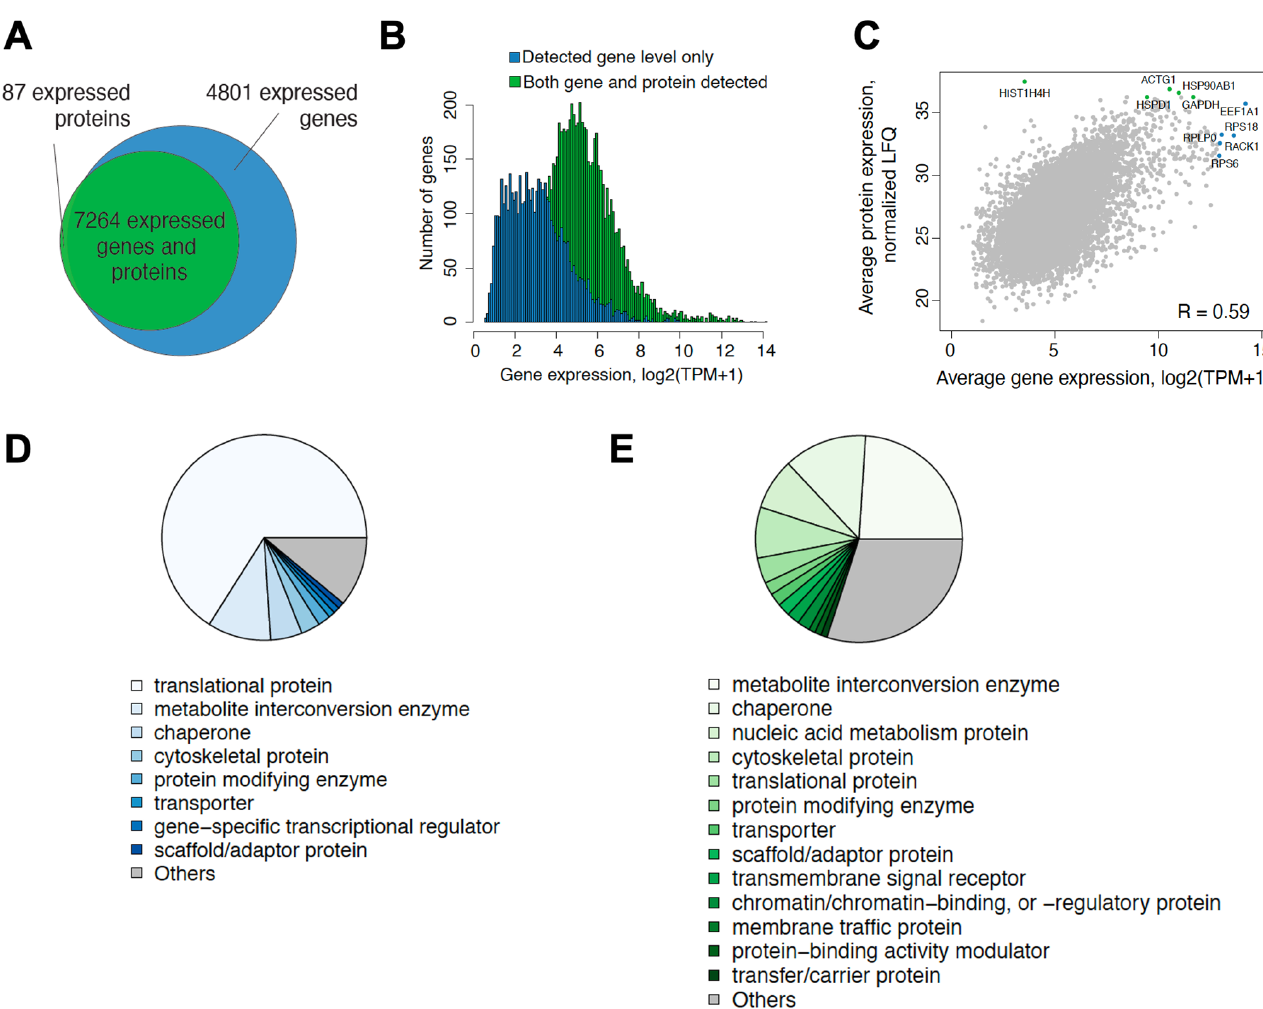
Figure 2. Comparison of expressed protein-coding genes and proteins detected in VCaP cells across all treatment conditions. For proteomic data analysis, proteins with signals in three replicates of at least one condition (N = 7427) were selected. ( A ) Euler diagram showing the overlap between the expressed protein-coding genes and corresponding proteins at both time points. ( B ) Histogram showing average expression (TPM) of genes detected only in RNA-seq (blue) or in both RNA-seq and proteomic data (green). ( C ) Scatter plot of average mRNA and protein expression. The top five most abundant genes and proteins are marked in blue and green, respectively. ( D ) Pie chart showing the functional classification of the most abundant genes (top 100 based on average expression across all treatment conditions). ( E ) Pie chart showing the functional classification of the most abundant proteins (top 100 based on average expression across all treatment conditions).